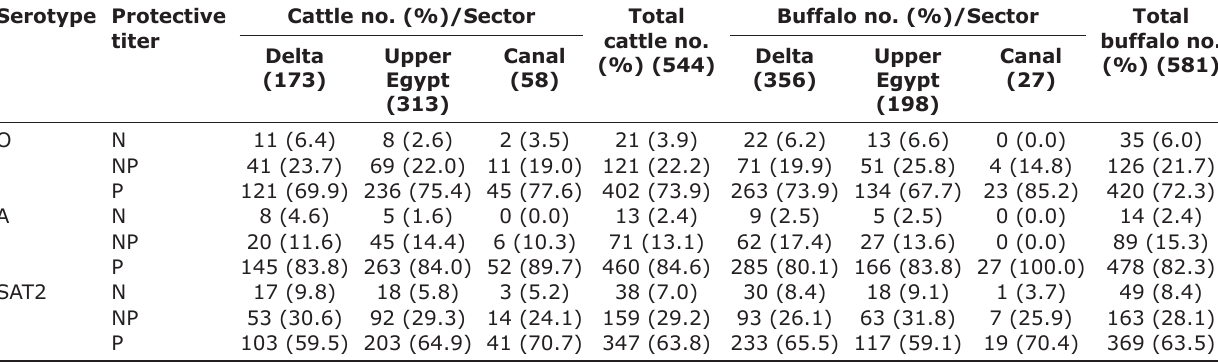
Table-3: Protective level of serotypes (O, A, and SAT2) included in trivalent FMD vaccine in negative NSP serum samples of cattle and buffaloes using SPCE. Serotype Protective Cattle no. titer